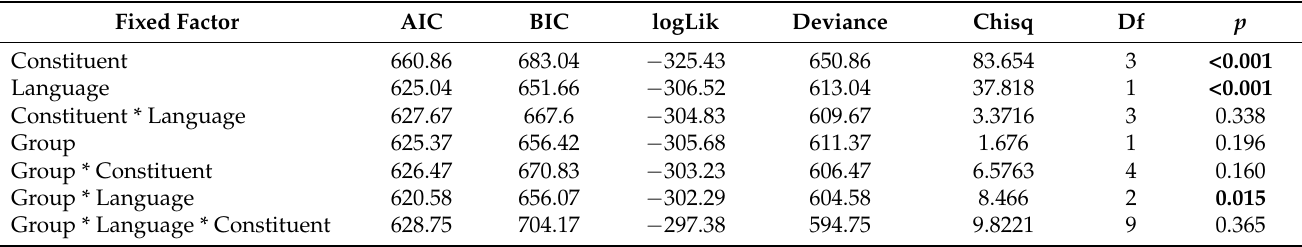
Table A3. Estimates of the GLMM model predicting the frequency of non-targeted CS by Constituent within the Temporal